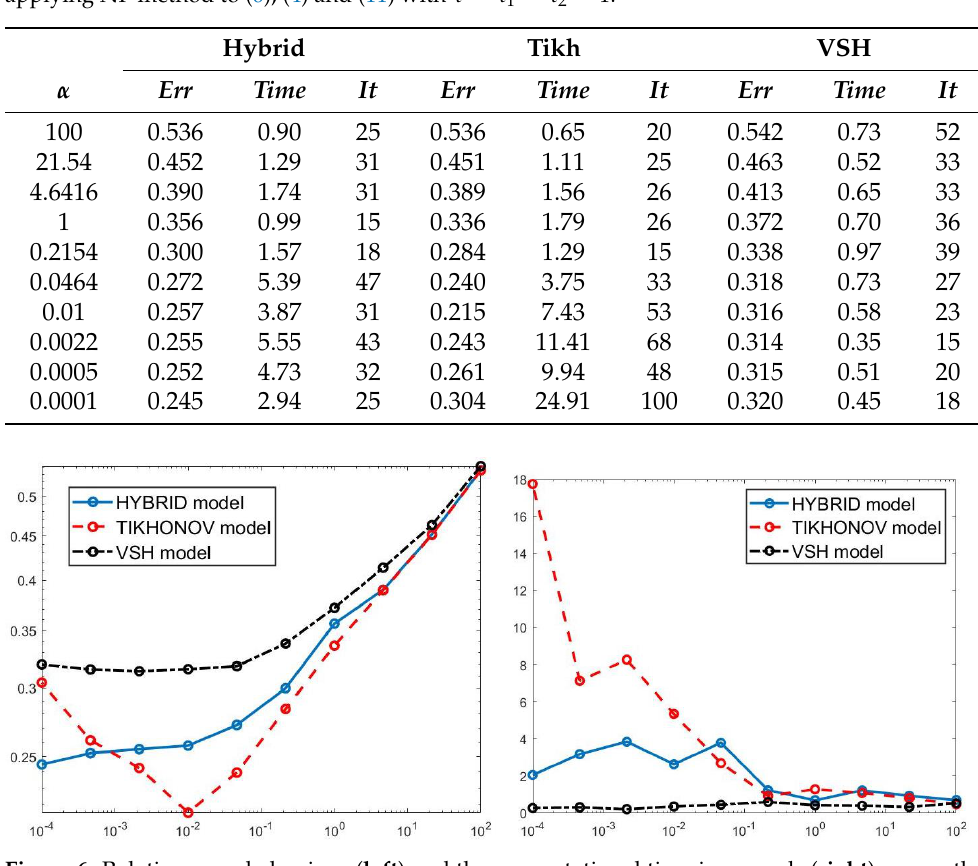
Figure 6. Relative error behaviour ( left ) and the computational time in seconds ( right ) versus the regularization parameter